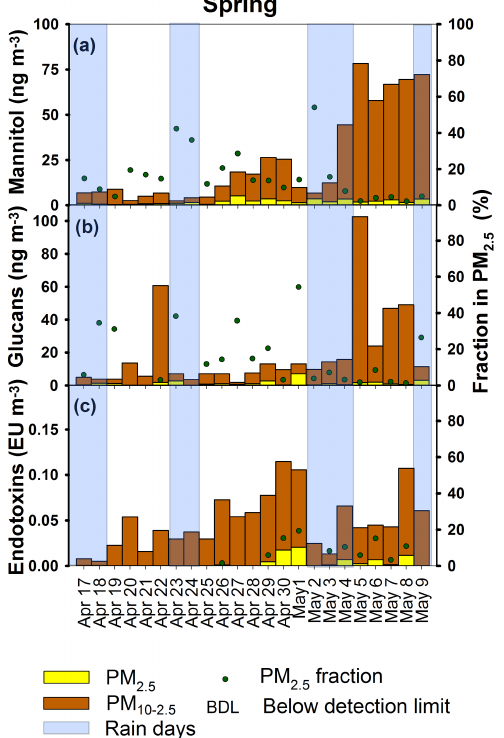
Figure 3. Ambient concentrations of mannitol (a) , glucans (b) , and endotoxins (c) in coarse and fine size fractions in Iowa City, IA, dur- ing spring of 2013. The percent of PM and bioaerosol tracer mass in fine particles is shown on the right axis for samples in which the analyte was detected in both size modes. Fungal spore tracers increased significantly on 5 May, following a rainy